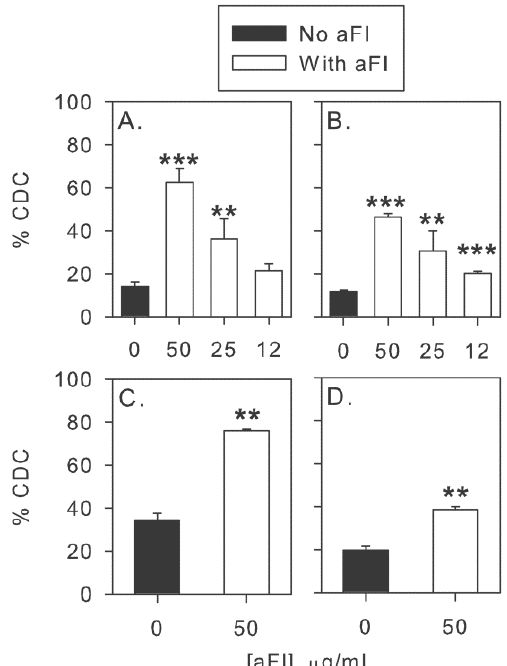
Figure 6. CDC, mediated by RTX or by OFA, of primary CLL cells is increased in the presence of mAb A247, specific for Factor I. ( A , B ) PBMC from Patient A ( A ) and Patient B ( B ) were subjected to CDC as in Figure 5, except the final concentration of RTX was 50 µg/mL and the concentration of mAb A247 was varied as indicated. ( C , D ) As in A,B, except OFA was present at 1.25 µg/mL. All incubations were for 15 min at 37 °C in 42%